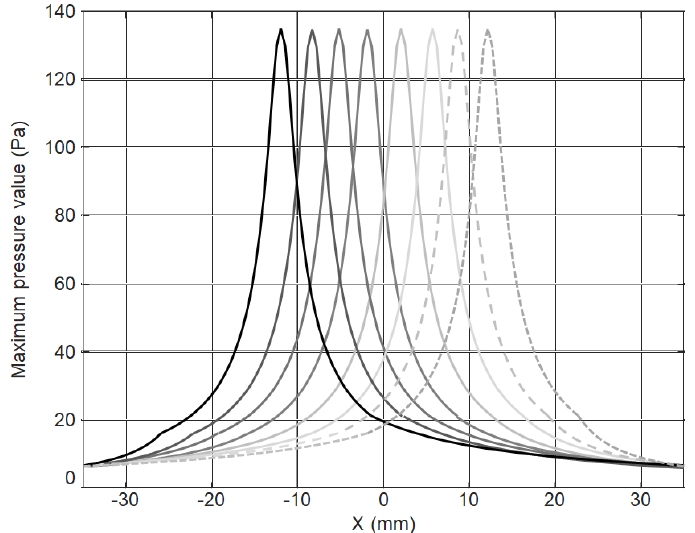
Figure 11. The spatial distribution of the acoustic pressure along the center line of the array at the distance R = 1 mm from the array at different time